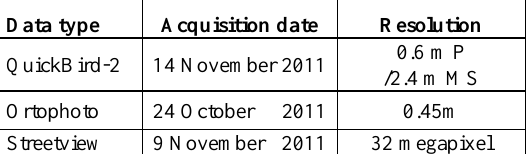
Table 1: Specifications of the different types of data used in this study.